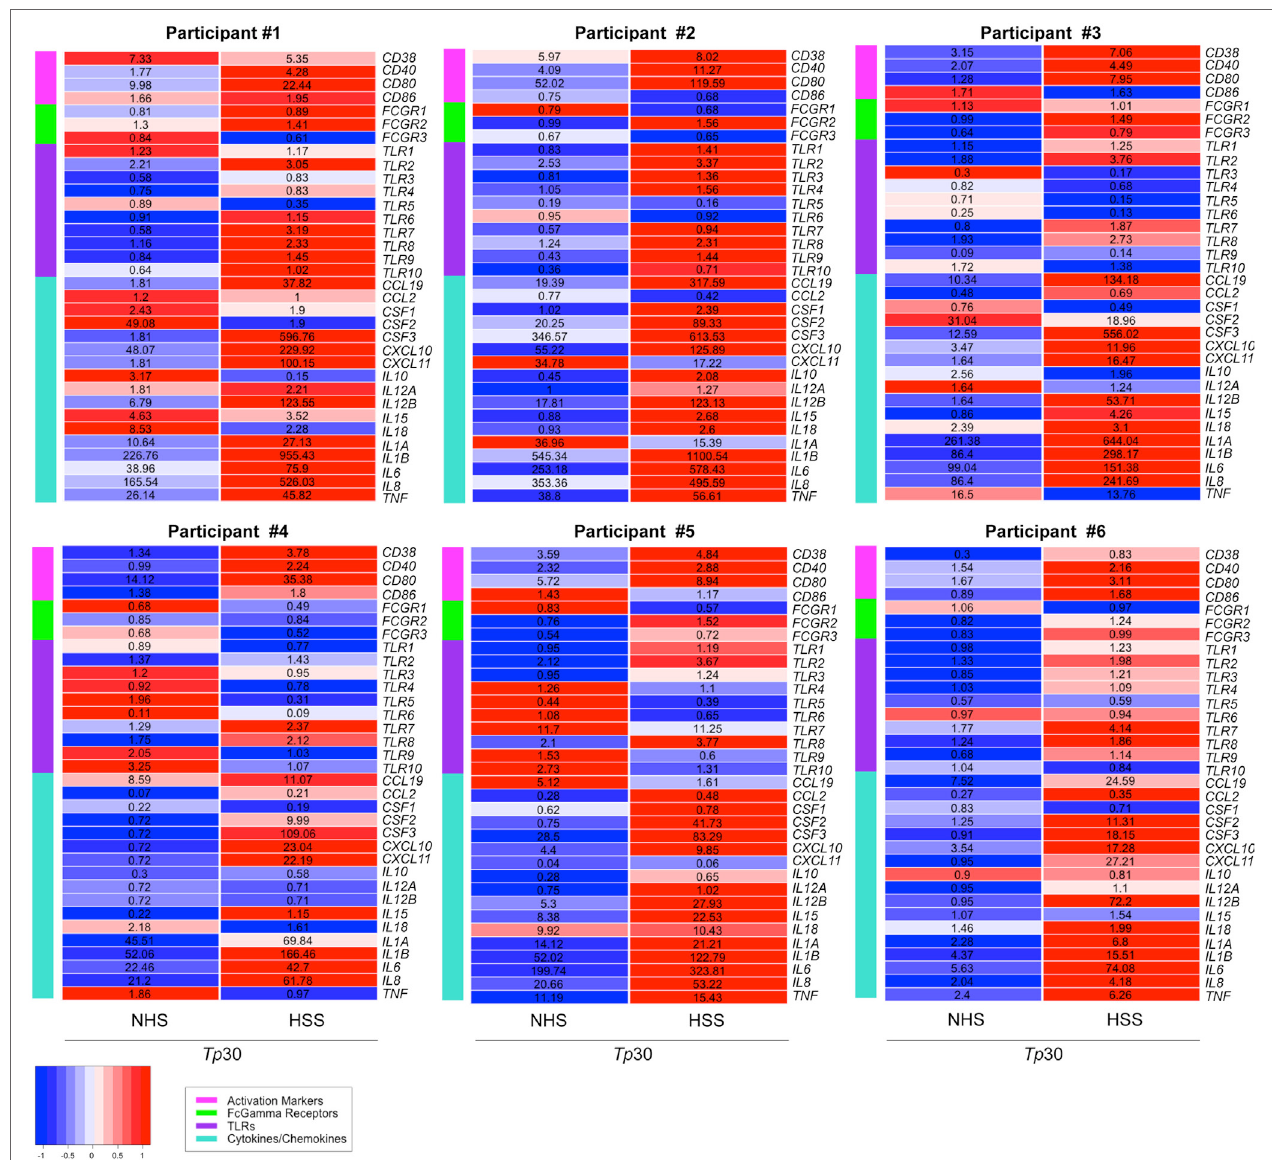
FigUre 5 | Transcriptional profile of M Φ (IFN γ ) stimulated with Treponema pallidum ( Tp ). Transcription profiles were determined by targeted array transcriptional analysis after stimulation of M Φ (IFN γ )s with unopsonized [no sera or normal human serum (NHS)] or opsonized [human syphilitic serum (HSS)] Tp (MOI 30:1) for 8 h in six-well tissue culture treated plates. Relative fold changes were normalized to the unstimulated M Φ (IFN γ )s control for each gene and then heat maps were generated based on gene categories of interest: activation markers, Fc γ receptors (Fc γ Rs), TLRs, and cytokines/chemokines. Heat maps depict the Z -score of NHS- Tp 30 and HSS- Tp 30, based on comparing all stimulation conditions, with relative fold-changes values in corresponding gene panel. Each heat map represents an N = 1 for individual participants, from a total of six independent